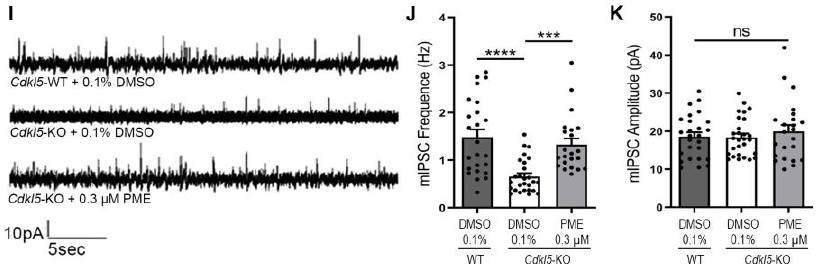
Figure 4. Treatment with PME normalises CDKL5-dependent inhibitory synaptic defects. ( A , C , E , G ) Representative images of Cdkl5 -WT/KO primary hippocampal neurons stained for MAP2 together with gephyrin (GPHN, red; A), GABA A R γ 2 (green, C), bassoon (red, E) or VGAT (green, G) upon treatment with 0.3 or 1 µM of PME or vehicle (0.1% DMSO) at DIV11 for 72 h. Scale bar, 5 µm. ( B , D , F , H ) Graphs showing the quantification of GPHN puncta ( B ), sGABA A R γ 2 fluorescence intensity ( D ), bassoon puncta ( F ), VGAT puncta ( H ) along 30 µm long dendritic segments. GPHN: n = 6